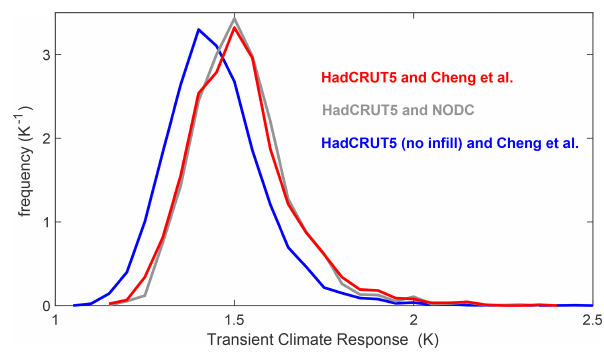
Figure 6. Transient climate response (TCR) for combinations of temperature and heat content datasets, evaluated from 1pctCO 2 sce- nario using the 20-year average warming centred on the moment of CO 2